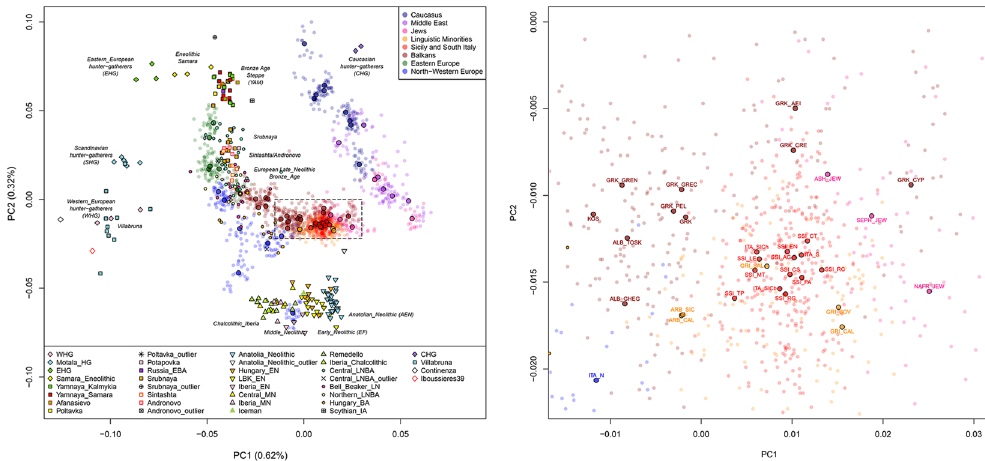
Figure 2. Principal component analysis performed on the extended comparison dataset with ancient samples projected onto the first two PCs. ( a ) Scatterplot of the first and second PCs for 1,469 modern samples from 68 Euro-Mediterranean populations and 263 projected ancient samples. Ancient individuals are labelled and symbol-coded according to their associated culture, as reported in the legend at the bottom of the plot and detailed in Supplementary Table S3. Modern individuals and median population coordinates (enlarged black- bordered circles) are colour-coded based on their geographic or ethnic affiliation, as in the legend at the top- right and in Supplementary Table S2. ( b ) A magnification of the plot details the position of the newly analysed Southern Italian and Southern Balkan populations within the observed large-scale genetic diversity.